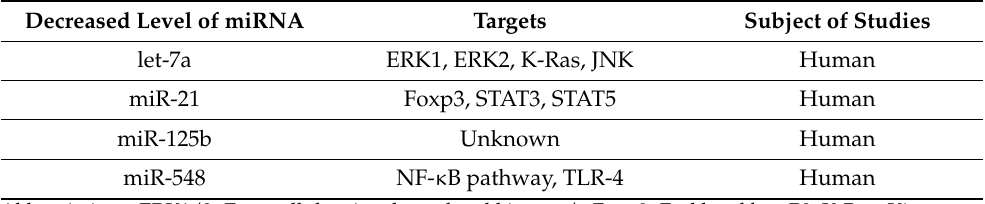
Table 2. List of decreased levels of miRNA in PBMCs with their targeted genes